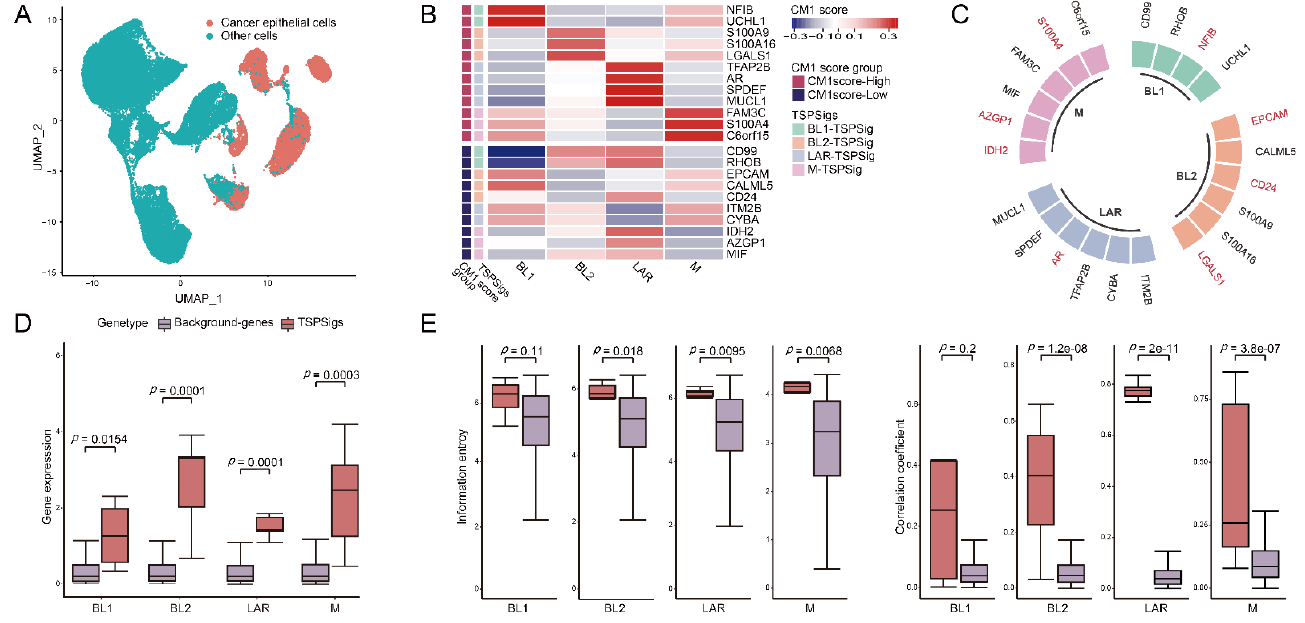
Figure 2. Identification of TSPSigs. ( A ) UMAP plot for the TNBC cancer epithelial cells and other cells in GSE176078. ( B ) Heatmap showed the CM1 scores of genes in TSPSigs. Annotated row: ( 1 ) CM1 score group: positive- and negative-CM1 scores were colored in red and purple, respectively, and ( 2 ) TSPSigs. ( C ) Plot for the known TNBC disease genes (colored in red) in each TSPSig. Differences between TSPSigs and the background genes in ( D ) the gene expression, ( E ) information entropy, and the inter-gene expression correlation.